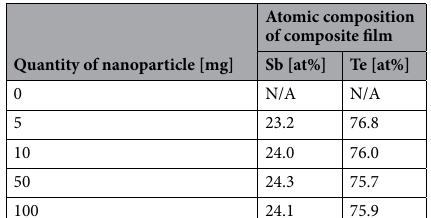
Atomic composition of composite